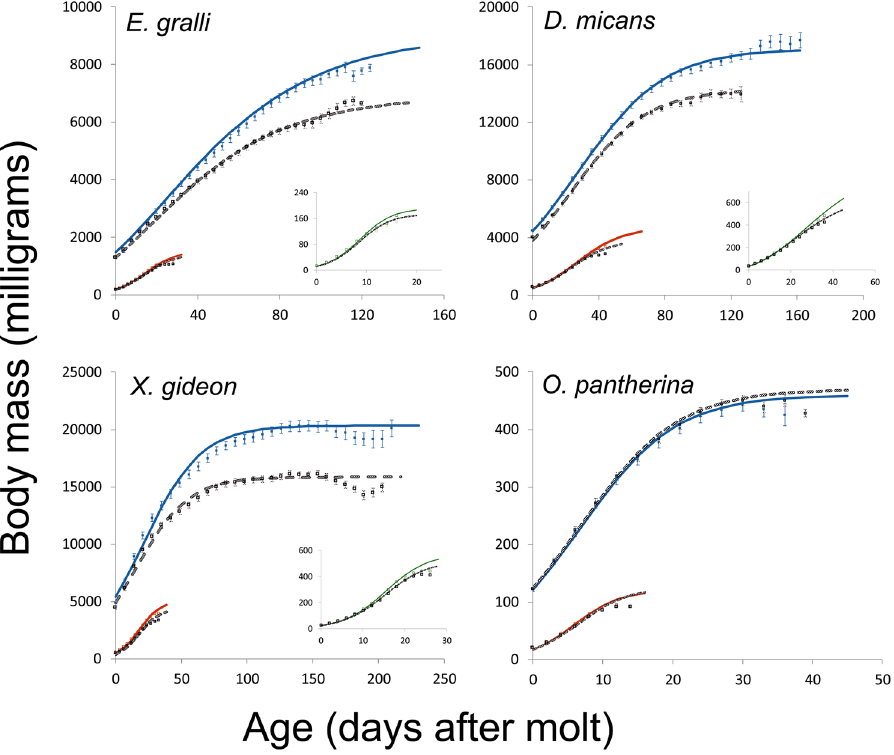
Figure 2. Mean growth trajectories of males (colour symbols) and females (gray symbols) of E . gralli , D . micans , O . pantherina and X . gideon within individual instars. The main pictures depict the second (red) and the third (blue) instar, the inset images display the first instar (green). Body masses are depicted as means ± SE in particular measurements. Because of certain irregularities in the weighing intervals (see text for explanation), the missing values of mass in the particular time point were replaced by estimations based on the values taken in two adjacent time points assuming linear growth in this short interval. Solid lines represent estimated Gompertz or logistic growth curves for males, dashed lines for females. Because individual larvae differ in developmental time, values of mean body mass at the end of growth trajectories do not contain larvae with distinctly shorter